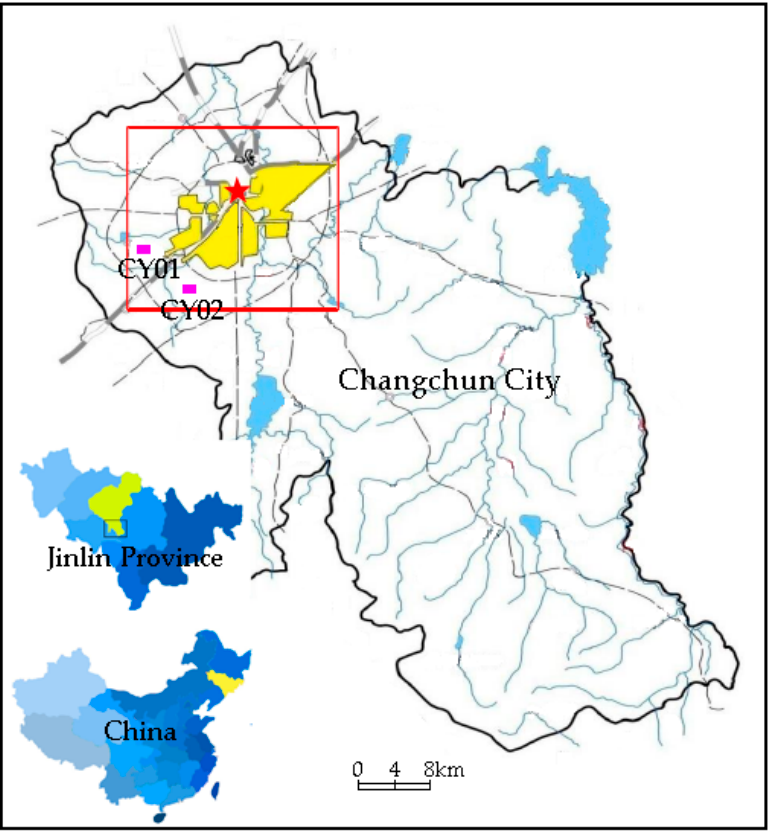
Figure 2. Study region location.